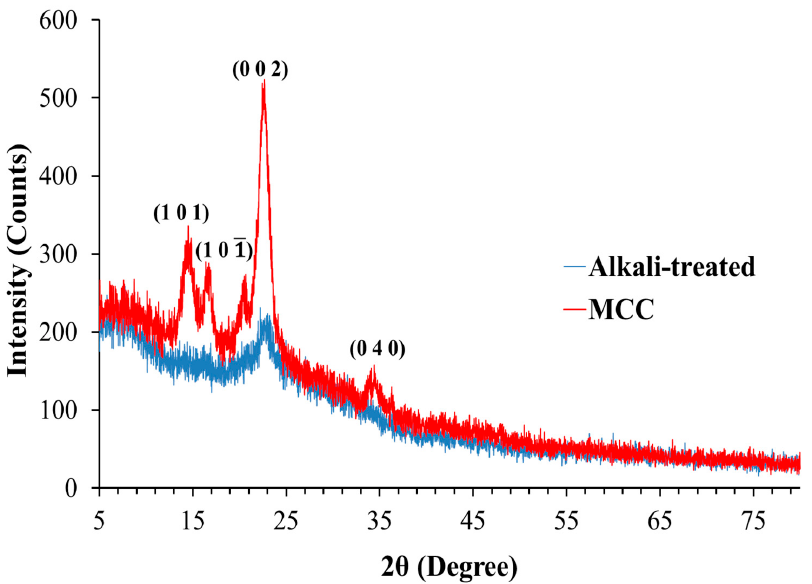
Figure 3. The X-ray diffractograms of alkali-treated fibers and MCC obtained from the Lagenaria siceraria fruit pedicle.